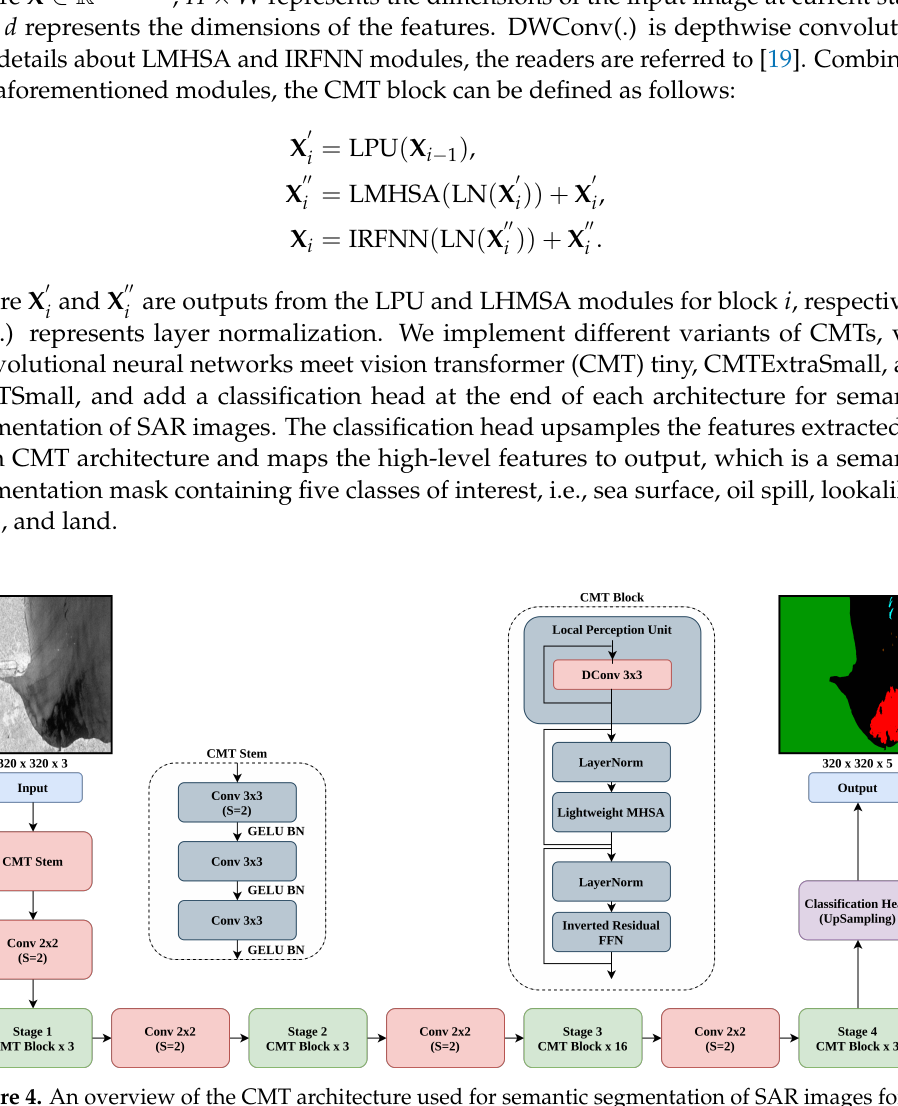
Figure 4. An overview of the CMT architecture used for semantic segmentation of SAR images for oil spill classification. The architecture is based on two modules, viz., CMT stem and CMT block. Each CMT block consists of LPU, LHMSA, and IRFNN modules. For our classification problem, the input is a 320 × 320 × 3 SAR image and output is a 320 × 320 × 5 semantic segmentation mask with five desired